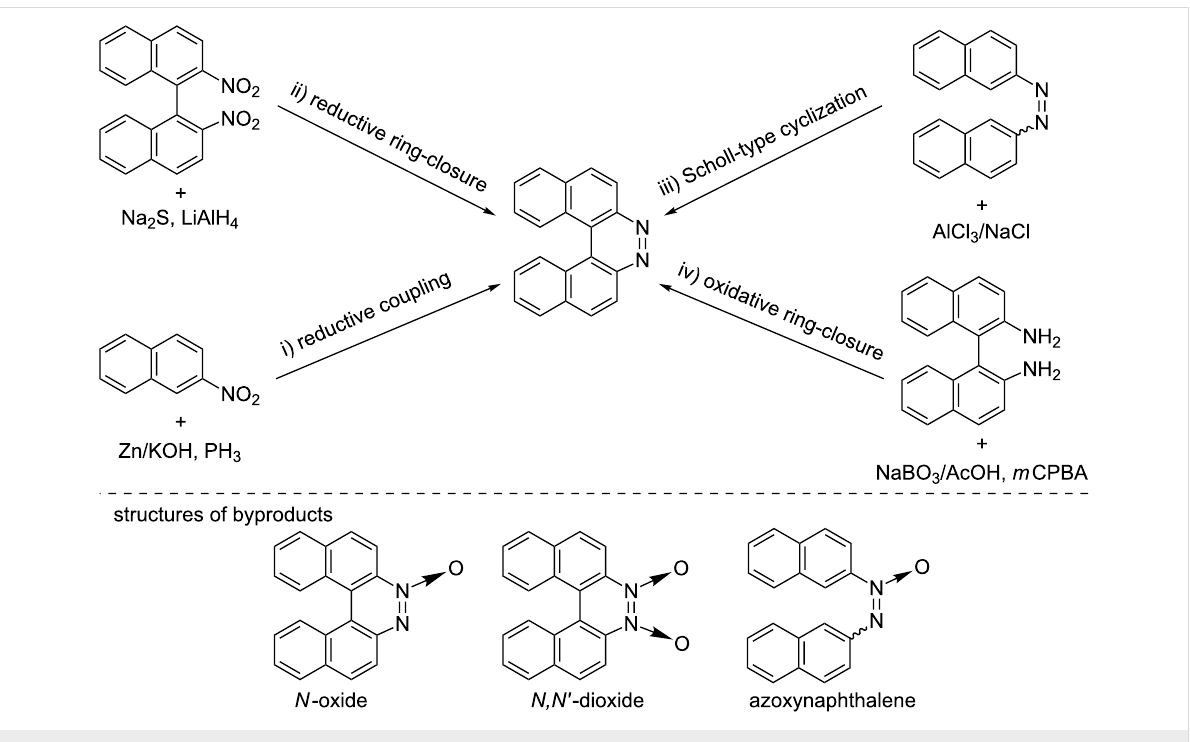
Scheme 1: Synthetic routes to